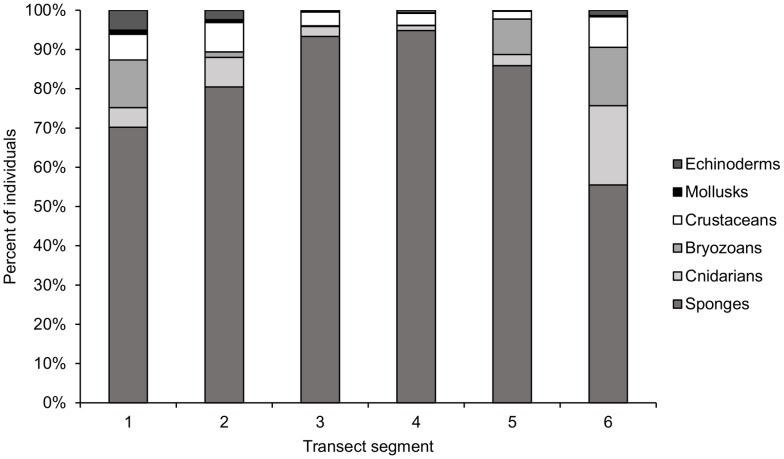
Percent of fauna belonging to each phylum on each transect segment.